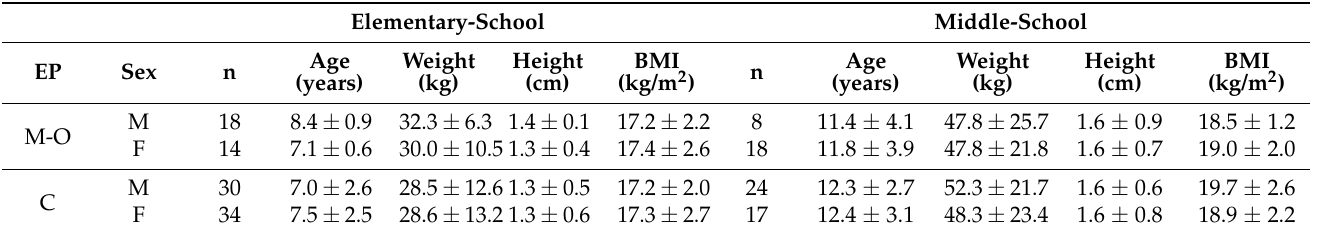
Table 1. Participants’ characteristics (elementary and middle school students).